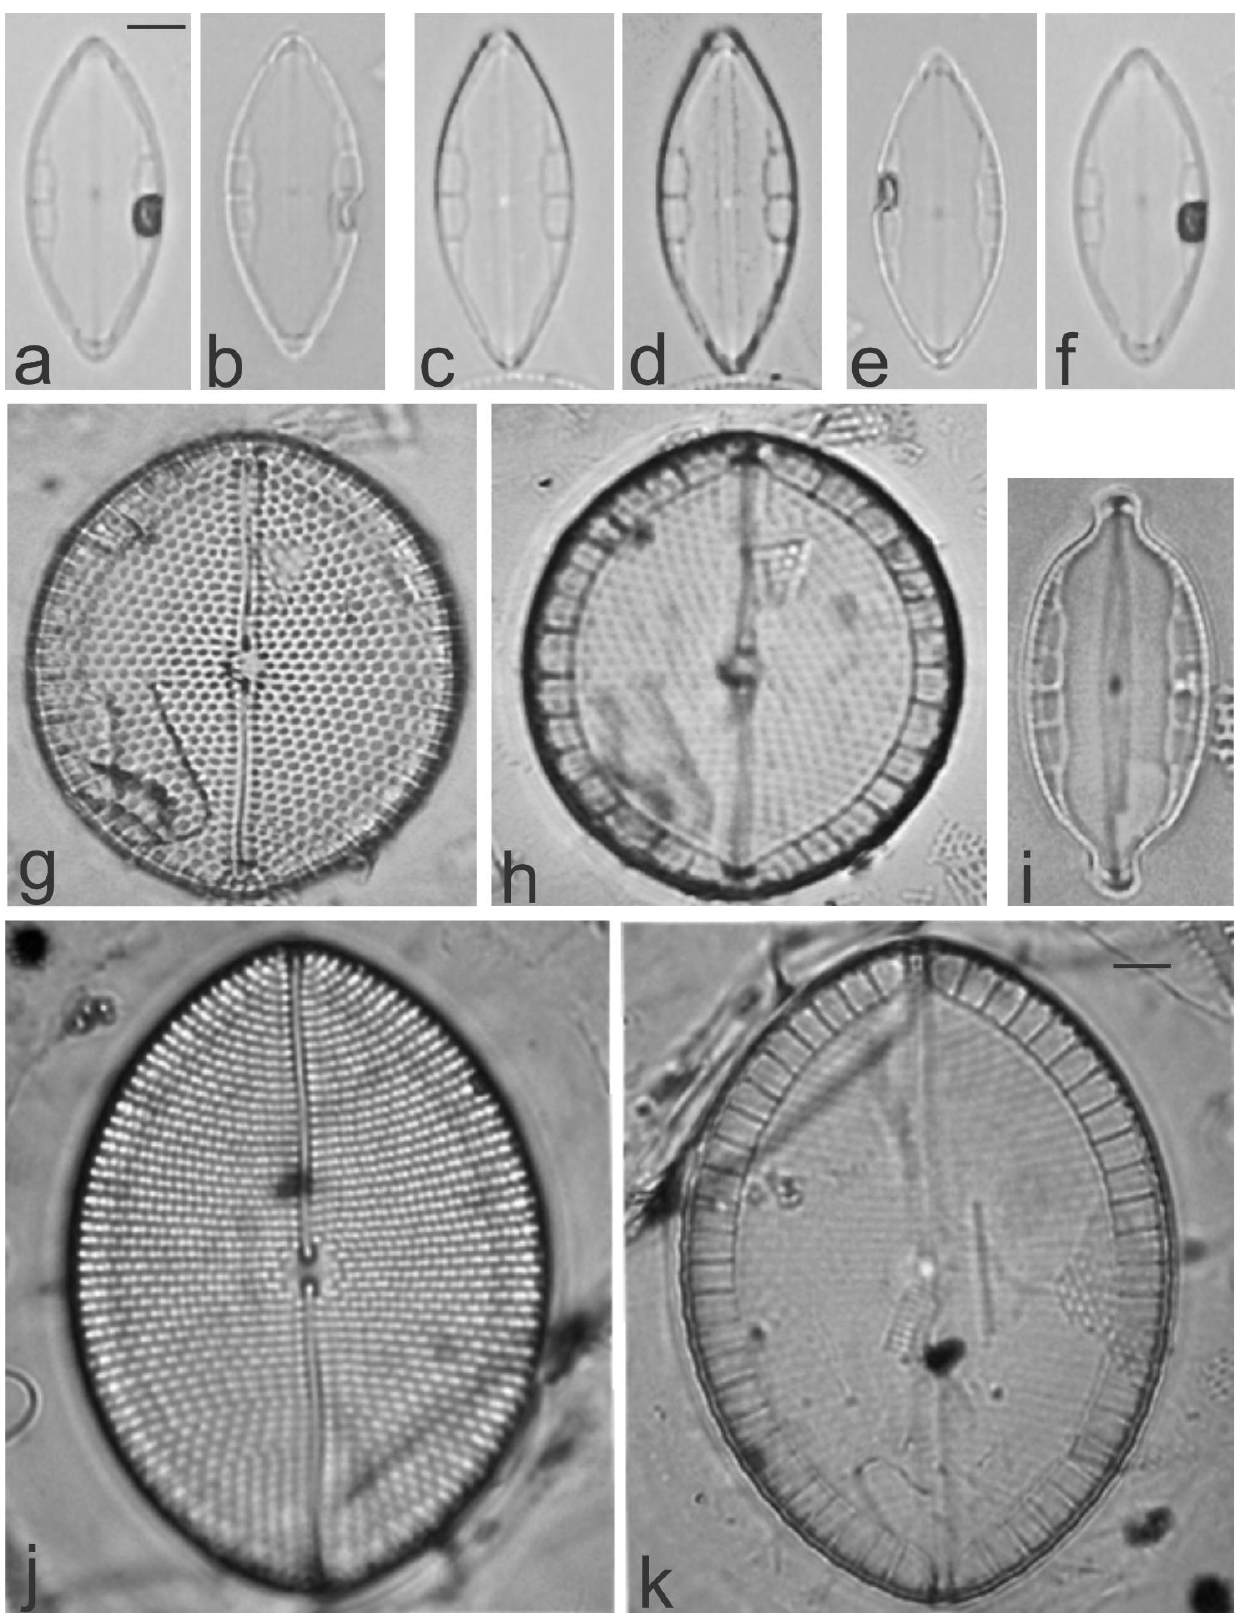
Figure 19. ( a – f ) Mastogloia pseudoexigua ; ( g , h ) M. cribrosa ; ( i ) M. acutiuscula var. elliptica ; ( j , k ) M. pseudolatecostata . Scale bars: ( j , k ) = 5 μm; all others = 4 μm.